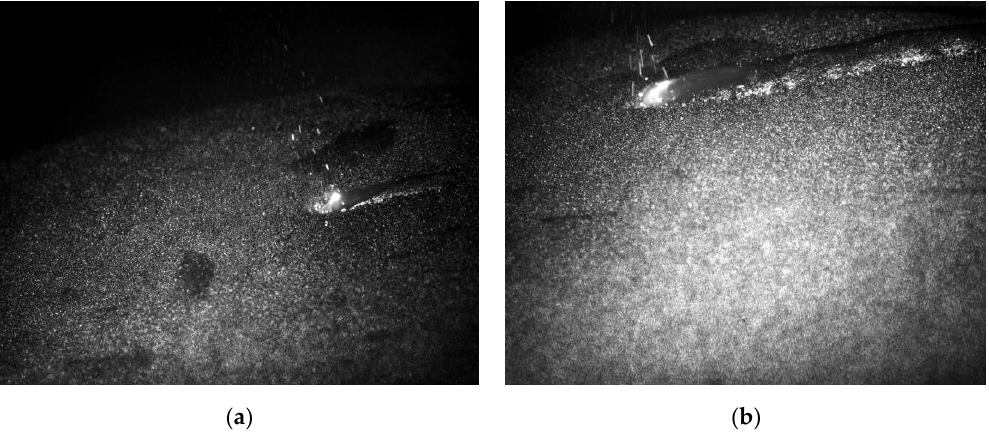
Figure 9. Snapshot of the online molten pool under SLM formation: ( a ) Molten pool; ( b ) Molten pool belt.